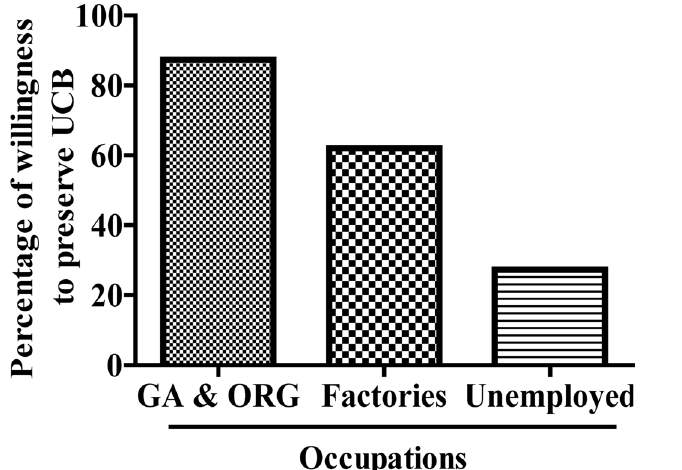
Fig 2. Effect of occupations on willingness to preserve